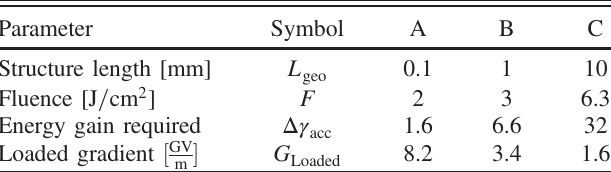
TABLE III. Typical values of energy gain and loaded gradient for three cases, each case corresponds to a different regime of the fluence.